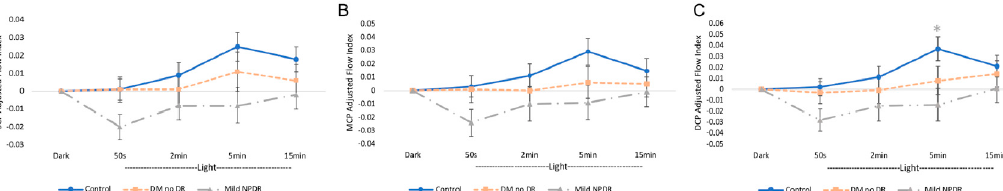
Figure 6. Parafoveal adjusted flow index on OCTA during ambient light transition. Adjusted flow index (AFI) in ambient light at each timepoint in ( A – C ) are shown as values relative to the dark, which was set to zero. ( A ) demonstrates ambient light AFI changes in the superficial capillary plexus of the three groups. ( B , C ) show a general trend of an increase in AFI in ambient light that peaks earlier and higher (at 5 min) in the middle, and deep capillary plexuses of the control group and later and lower in the diabetic groups. In the deep capillary plexus (DCP), the peak AFI at 5 min in the control group is significantly higher than the DCP AFI of the mild NPDR group. All timepoint(s) with statistically significant di ff erences ( p < 0.05) between the diabetic and control conditions are marked with an asterisk (*) and the color of the asterisk corresponds with the respective diabetic group that is di ff erent from the control. Error bars represent standard errors. Abbreviations: SCP—superficial capillary plexus, MCP—middle capillary plexus, DCP—deep capillary plexus, s—seconds,